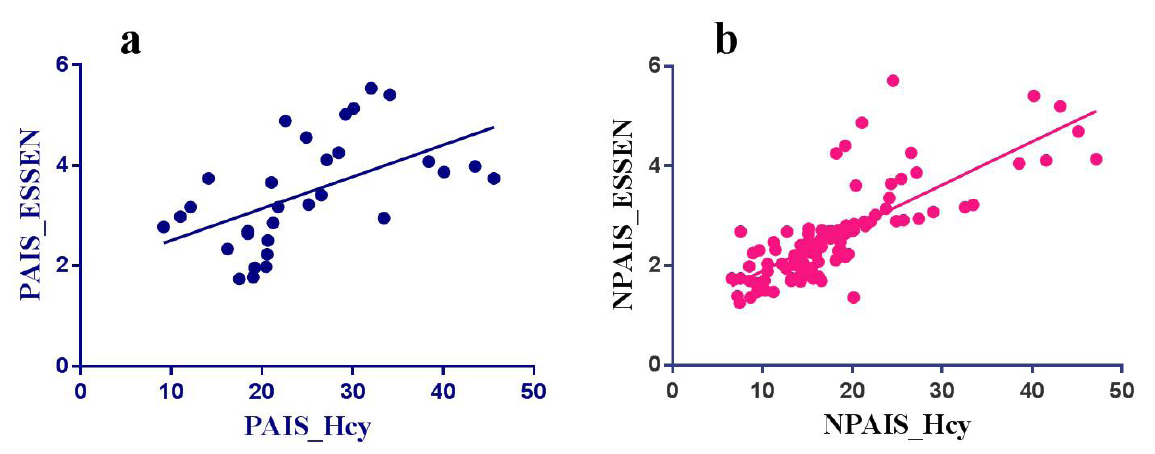
Figure 4: Pearson correlation between Hcy and ESRS in PAIS and NPAIS patients(a:PAIS patients; b:NPAIS